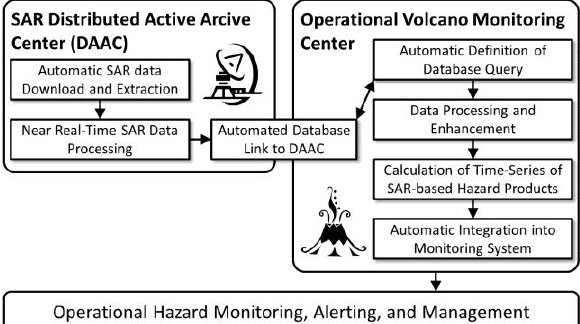
Figure 1. Conceptual design of the integration of SAR data into an existing operational volcano monitoring